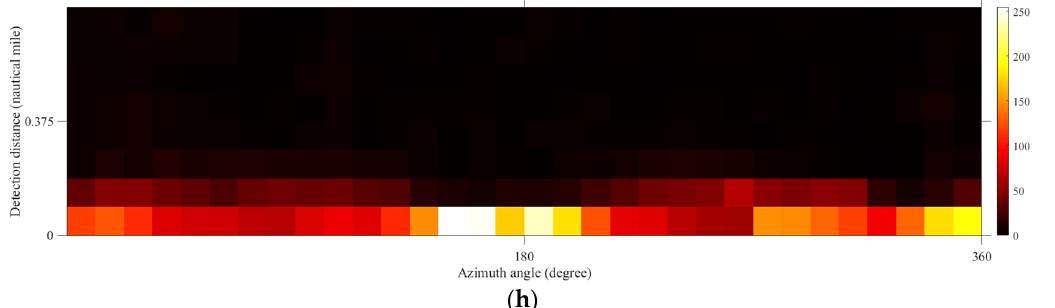
Figure 6. Experimental image texture features: ( a ) energy; ( b ) entropy; ( c ) contrast; ( d ) mean; ( e ) homogeneity; ( f ) dissimilarity; ( g ) correlation; ( h ) variance.